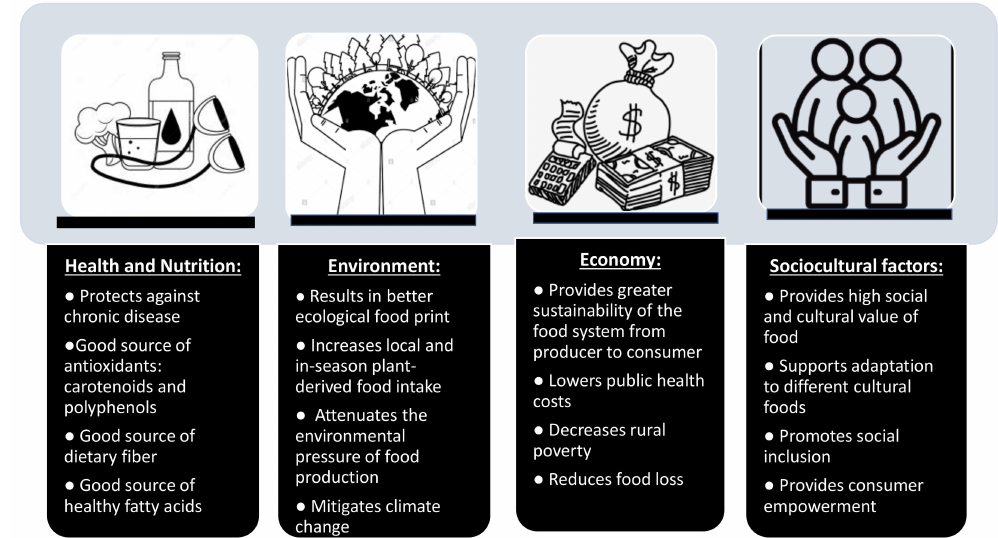
Figure 4. The updated Mediterranean Diet Pyramid is characterized for its contribution to Health and Nutrition, the Environment, the Economy and the incorporation of Sociocultural Factors. Some of the elements supporting these claims are depicted in this